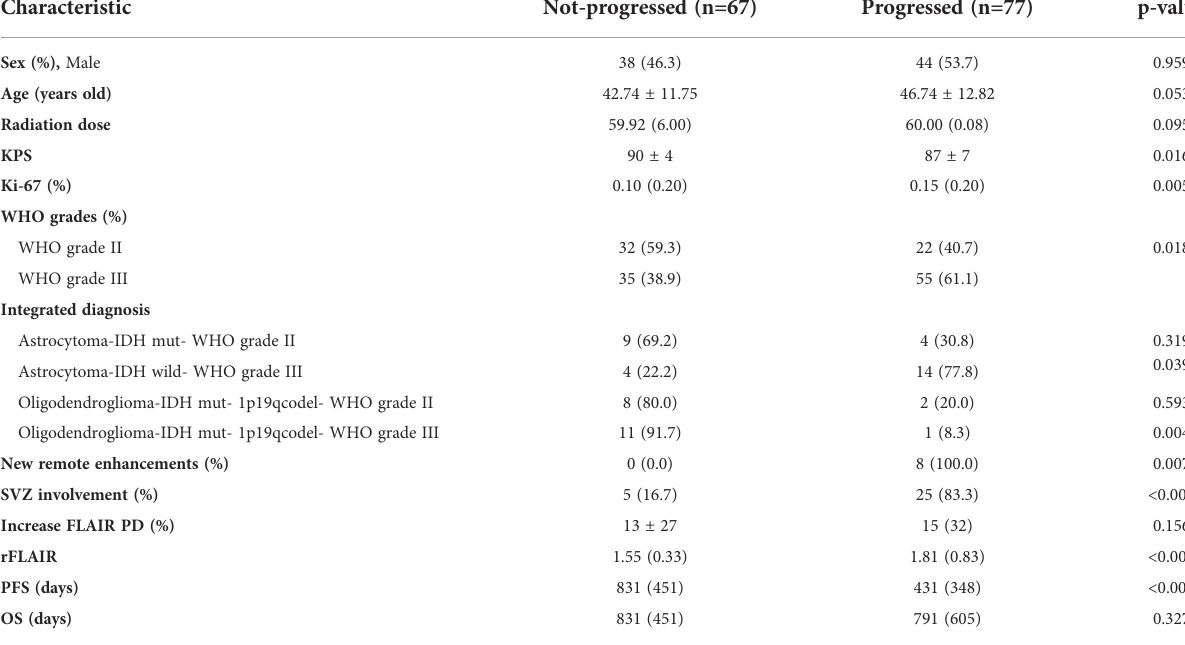
TABLE 1 Baseline characteristic of posttreatment patients with lower-grade glioma (LGG; n=144).